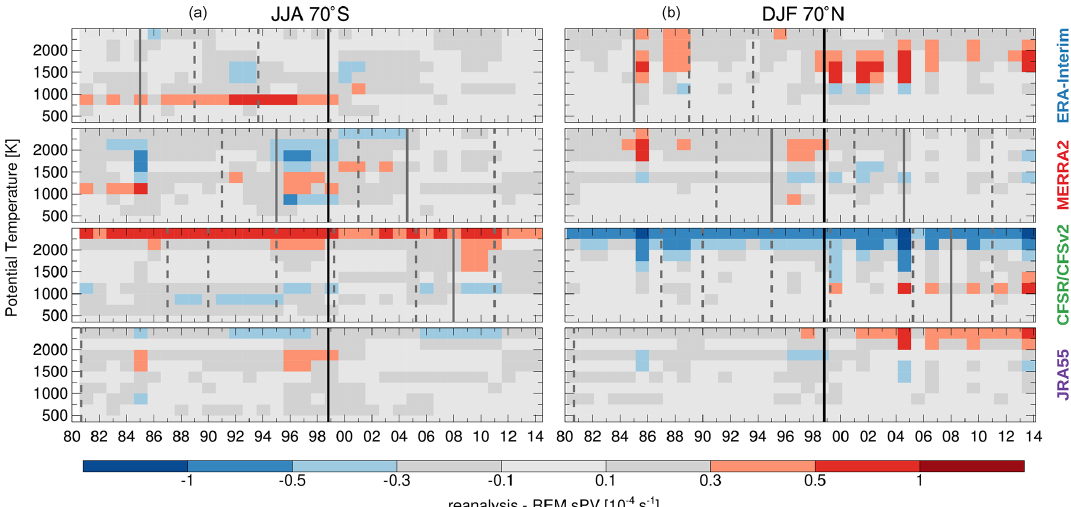
Figure 4. sPV differences for each reanalysis from the REM as a function of year and potential temperature. (a) JJA at 70 ◦ S and (b) DJF at 70 ◦ N differences. Vertical lines show the discontinuities associated with changes in assimilated datasets (solid lines) or different processing streams (dashed lines).